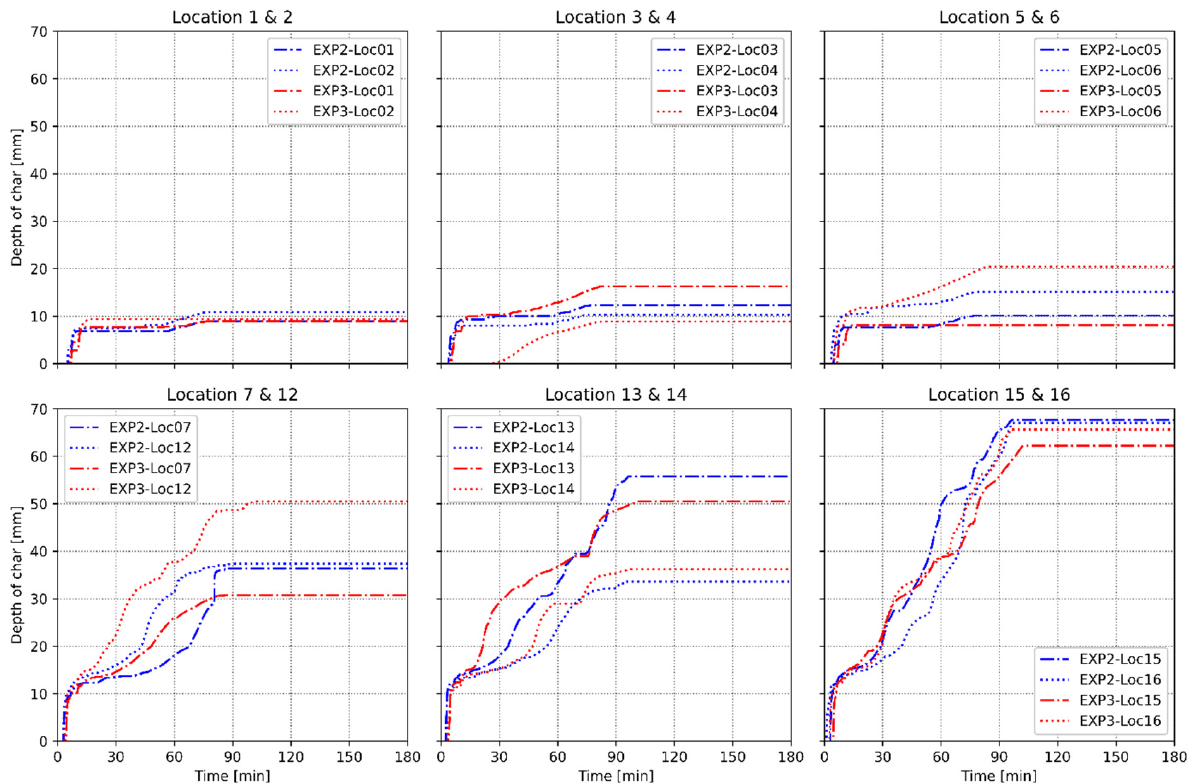
Figure 14. Charring depth with time estimated from 300 °C isotherm position for Experiments 2 and 3.